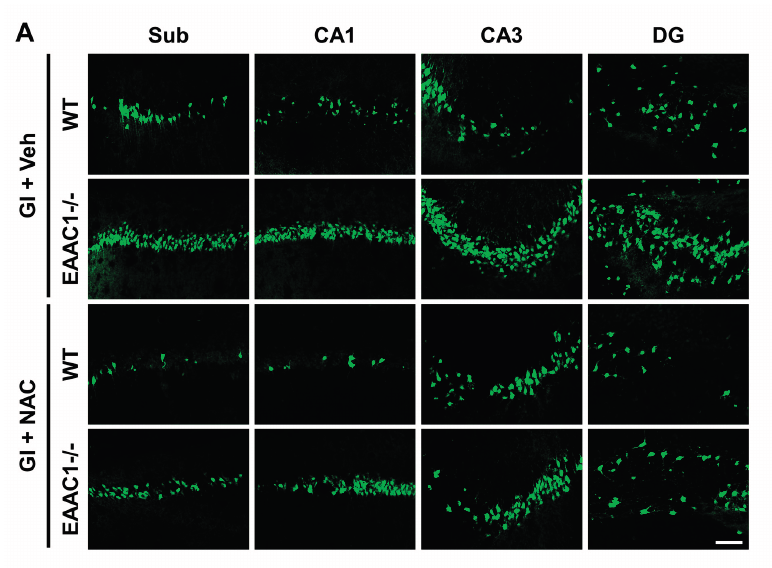
female mice. Neuronal death was detected by Fluoro Jade-B staining. ( A ) EAAC1 − / − female mice show more neuronal death than wild-type female mice after ischemia. Fluorescence images show neuronal death in hippocampal subiculum (Sub), CA1, CA3 and dentate gyrus (DG) at 3 days after transient global ischemia. Widespread Fluoro-Jade B (FJB)-positive neurons appeared in ischemia experienced wild-type (WT) mice. The number of FJB-positive neurons was significantly increased in EAAC1 − / − mice. NAC treatment reduced neuron death (FJB (+) neurons) in the hippocampal subiculum (Sub), CA1, CA3 and dentate gyrus (DG) either in wild-type or in EAAC1 − / − mice 3 days after ischemia. Scale bar = 100 μ m; ( B ) Bar graph shows the quantified neuronal degeneration in hippocampal Sub, CA1, CA3 and DG from wild-type and EAAC1 − / − mice. Data are mean + S.E.M.; n = 8–10, #, * p <